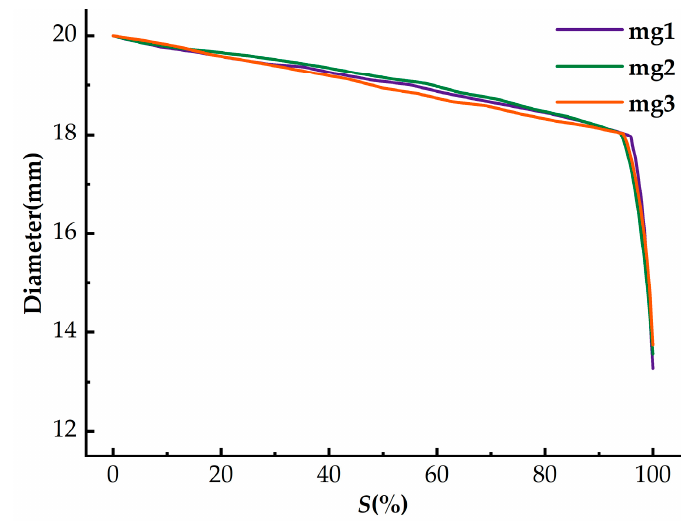
Figure 6. Diameter variation curve of bolt necking part.